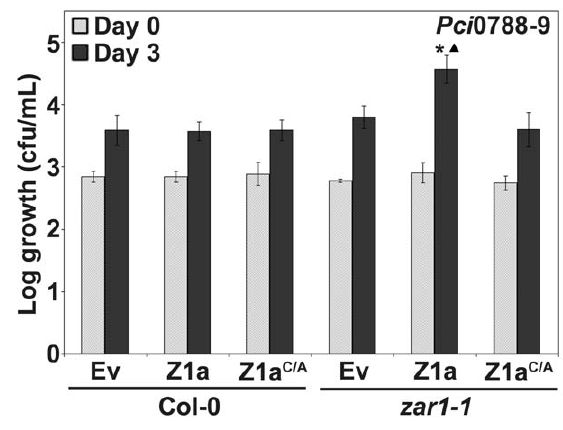
Figure 4. HopZ1a has a virulence function in zar1-1Arabidopsis plants. Pci 0788-9 expressing the indicated construct was syringe infiltrated at 1 6 10 5 cfu/mL into Arabidopsis Col-0 or zar1-1 leaves and bacterial counts were determined one hour post-infection (Day 0) and 3 days post-infection (Day 3). C/A indicates the C216A mutation of HopZ1a in the predicted catalytic triad and the mutant protein is expressed at a similar level to HopZ1a [39]. Two-tailed homoschedastic t-tests were performed to test for significant differences. Within a plant genotype, treatments were compared to empty vector and significant differences are indicated by an asterisk (* P , 0.01). To compare between plant genotypes, growth of Pci 0788-9 carrying HopZ1a, or HopZ1a C216A (HopZ1a C/A ) was normalized to the average growth of Pci 0788-9(Ev). Significant differences between zar1-1 and Col-0 are indicated by a triangle ( m P , 0.01). Error bars indicate the standard deviation from the mean of 10 samples. Growth assays were performed at least 3 times.